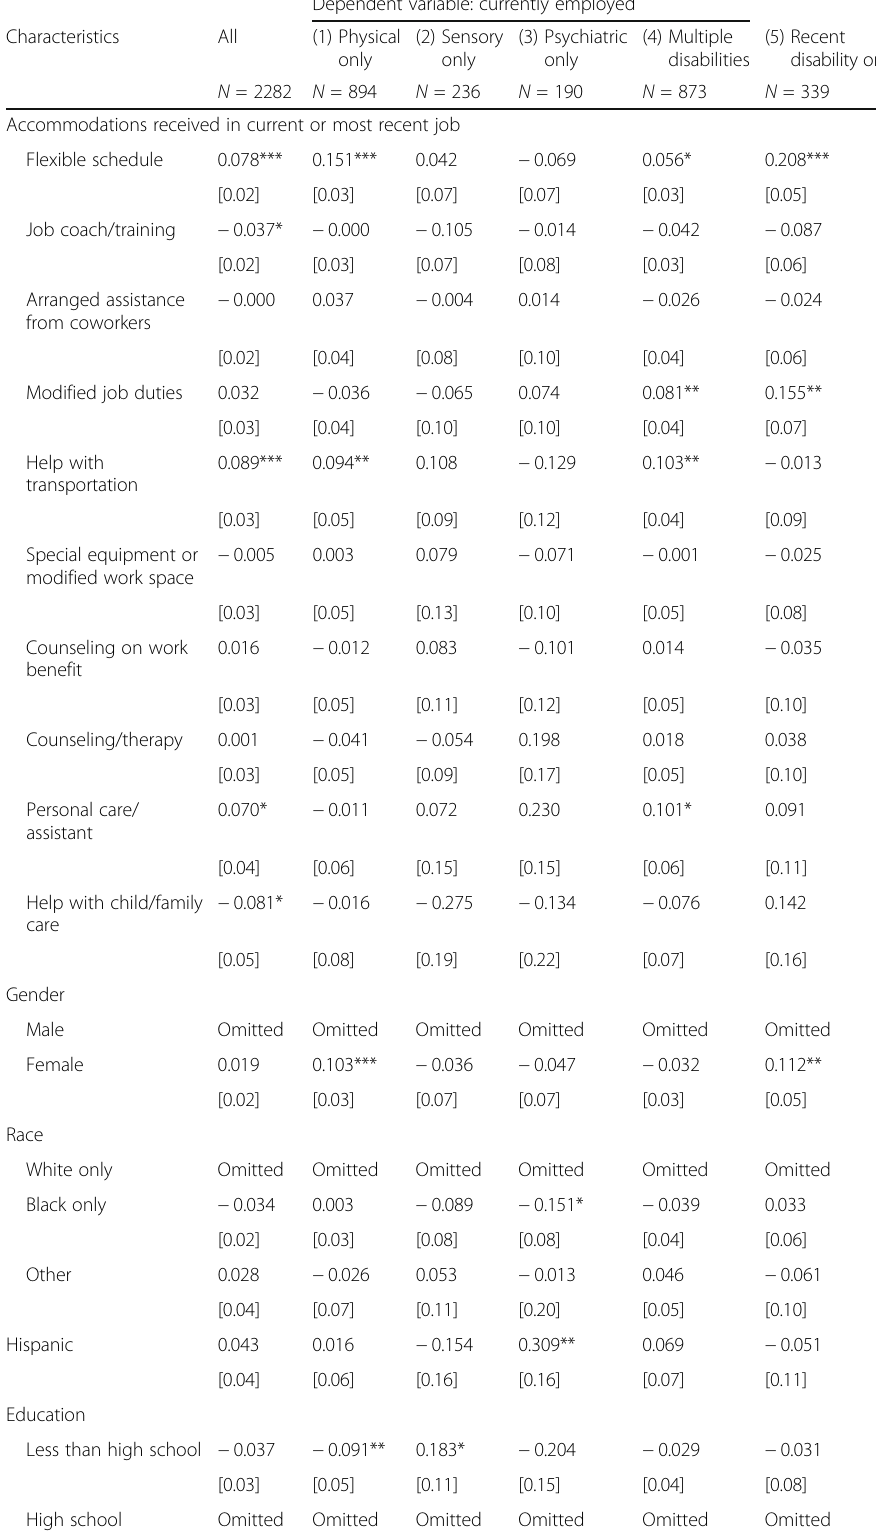
Table 4 Regression results of employment on workplace accommodations, overall, and by disability subgroup